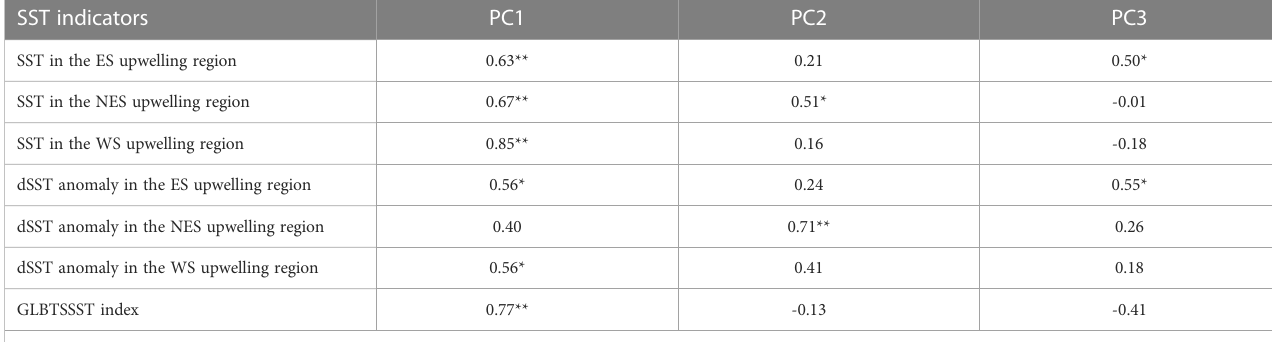
TABLE 1 Correlation coef fi cients between SST indicators and the PC values in the fi rst three modes of empirical orthogonal function analysis. SST indicators PC1 PC2 PC3 SST in the ES upwelling region 0.63** 0.21 0.50* SST in the NES upwelling region 0.67** 0.51* -0.01 SST in the WS upwelling region 0.85** dSST anomaly in the ES upwelling region 0.56* dSST anomaly in the NES upwelling region dSST anomaly in the WS upwelling region GLBTSSST index